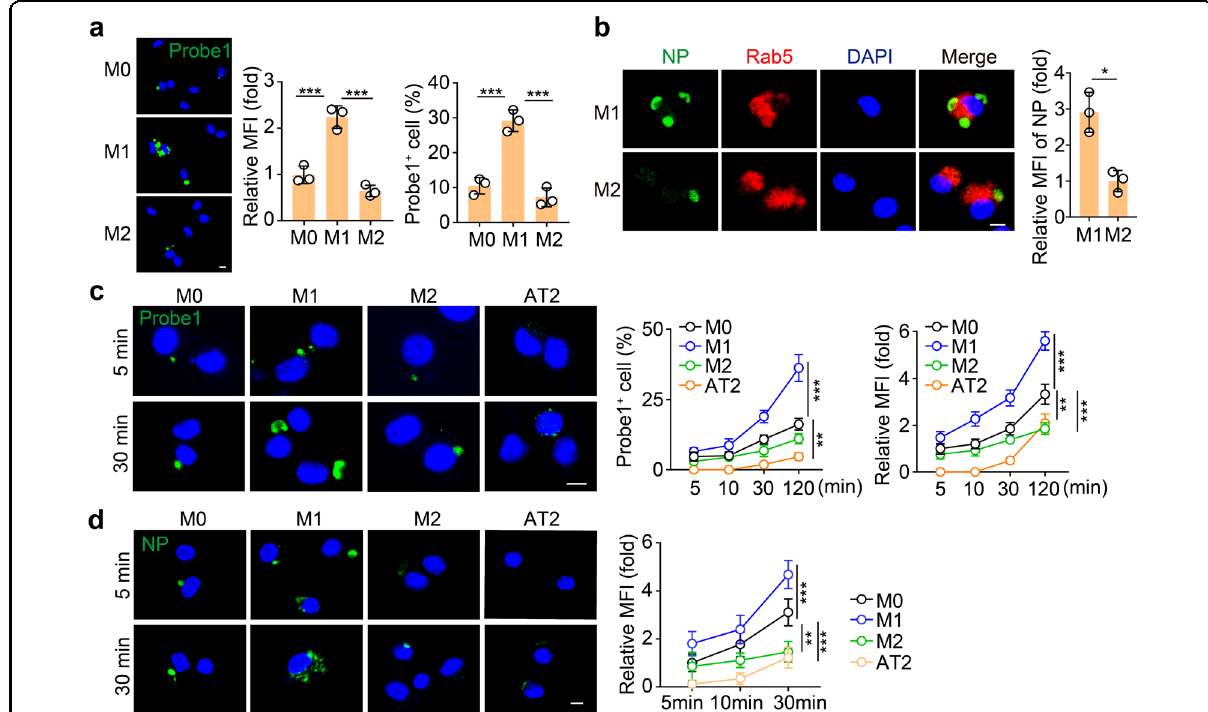
Fig. 1 M1 alveolar macrophages can ef fi ciently take up SARS-CoV-2. a The primary AMs were polarized to M1 by IFN- γ (20 ng/mL) and LPS (100ng/mL) or M2 by IL-4 (20 ng/mL) for 24 h, and then infected with SARS-CoV-2 at the ratio of 1:1 (TCID 50 : cells) for 2 h. Cells were fi xed for RNAscope analysis with SARS-CoV-2-speci fi c probes. Probe 1 targets viral positive-sense sequence to evaluate viral distribution (green color). Scale bar, 5 μ m. b M1 or M2 AMs infected with SARS-CoV-2 for 30 min were stained with anti-NP and anti-Rab5 antibodies and observed under a confocal microscope. Scale bar, 5 μ m. c M0, M1, or M2 AMs and primary alveolar epithelial (AT2) cells isolated from hACE2 mice were infected with SARS-CoV-2 for 5 min or 30 min and then fi xed for RNAscope analysis. Scale bar, 5 μ m. d Same as c , except that cells were stained with the anti-NP antibody. Scale bar, 5 μ m. The data represent the mean ± SD of 3 independent experiments. * P < 0.05, *** P < 0.001, by one-way ANOVA ( a , c , d